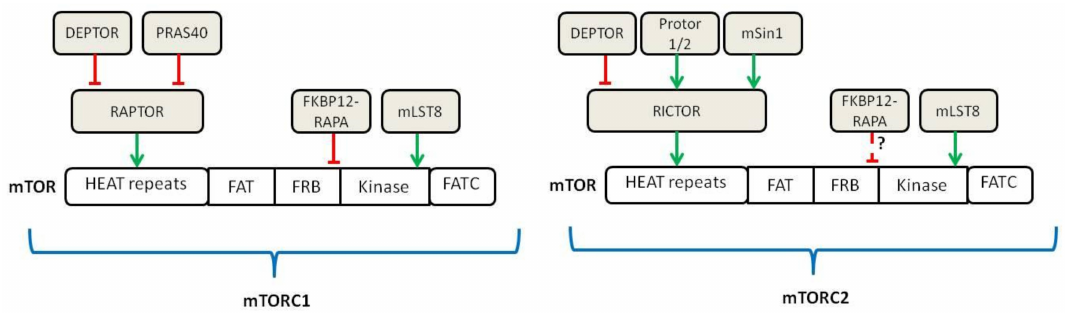
Figure 1. Schematic of the components belonging to mTORC1 and mTORC2 (adapted from [16]). Green lines show activating signals, red lines show inhibitory signals, dashed lines indicate that the exact mechanism is